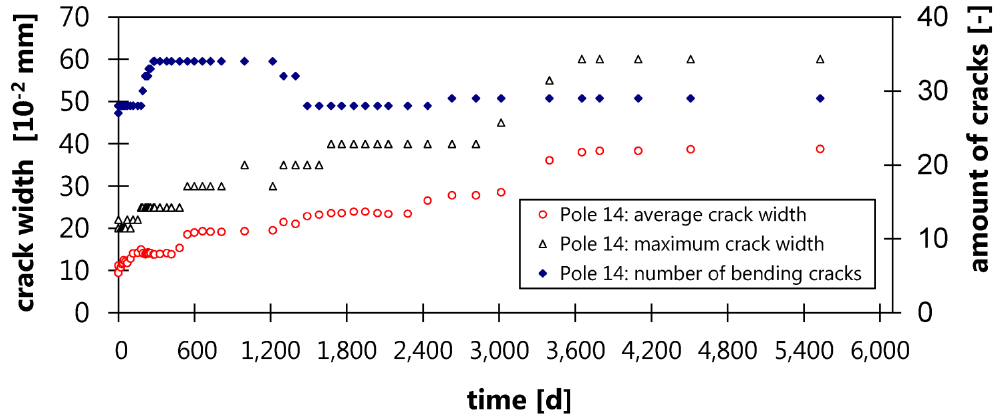
Figure 9. Development of the number of cracks and crack widths of the highest loaded pole, No.